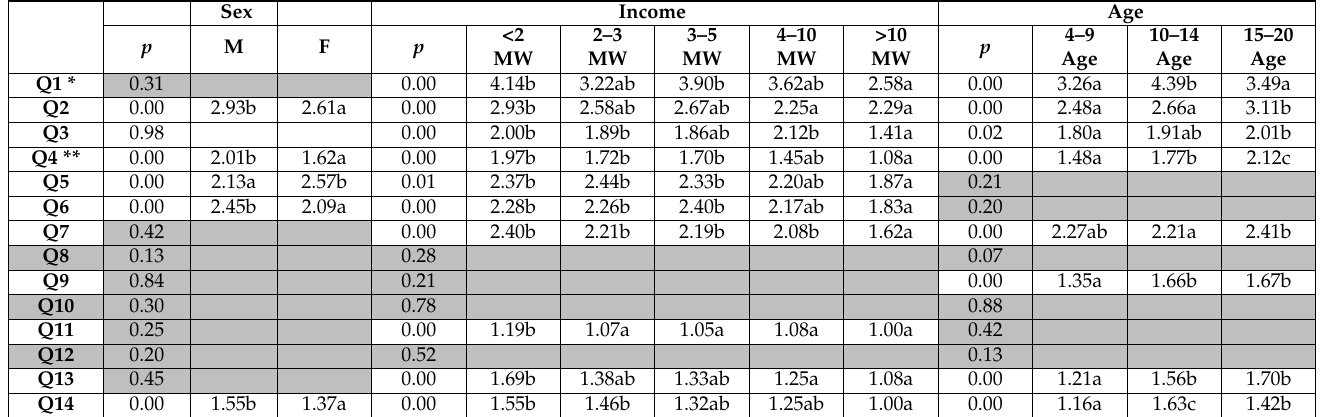
Values refer to original data, transformed using the Box–Cox transformation [35]. Means values followed by different letters differ from each other by the Tukey test at 5%. Letters were assigned in ascending order for each variable and variation source. Empty columns are nonsignificant variation sources by the F-test ( p ≥ 0.05). Gray cells were not significant variation sources. * Interaction between the variation sources sex vs. age